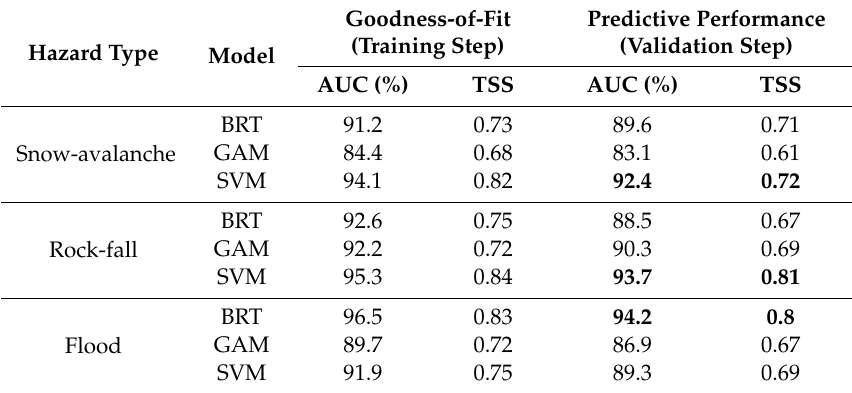
Figure 6. Flood hazard maps using: ( a ) BRT, ( b ) GAM, and ( c ) SVM. Table 3. Goodness-of-fit and predictive performance of models for three hazard types.